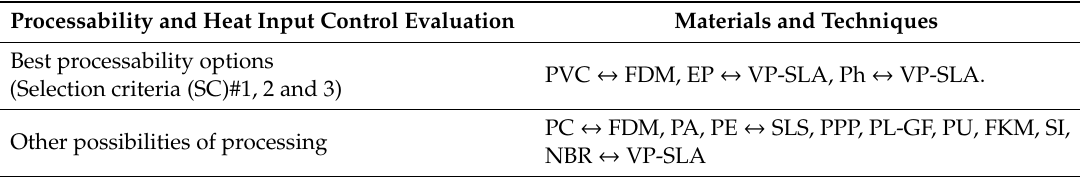
Table 7. Materials and techniques according to processability analysis.